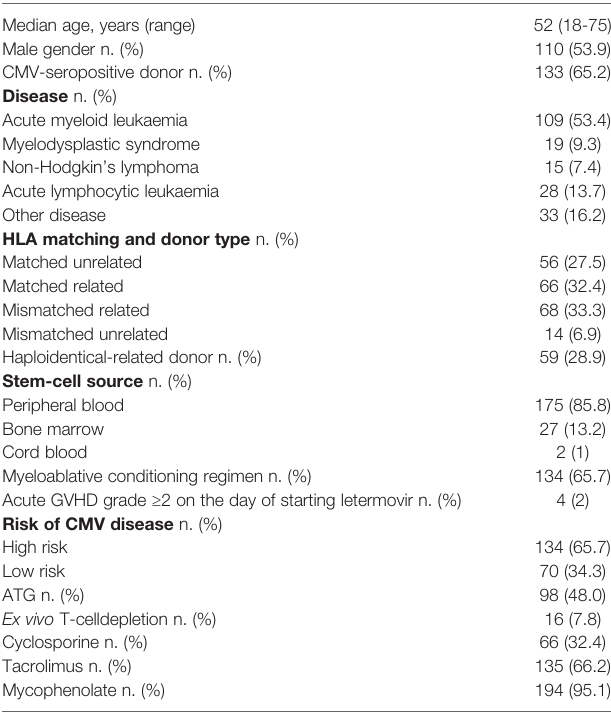
TABLE 1 | Baseline patients ’